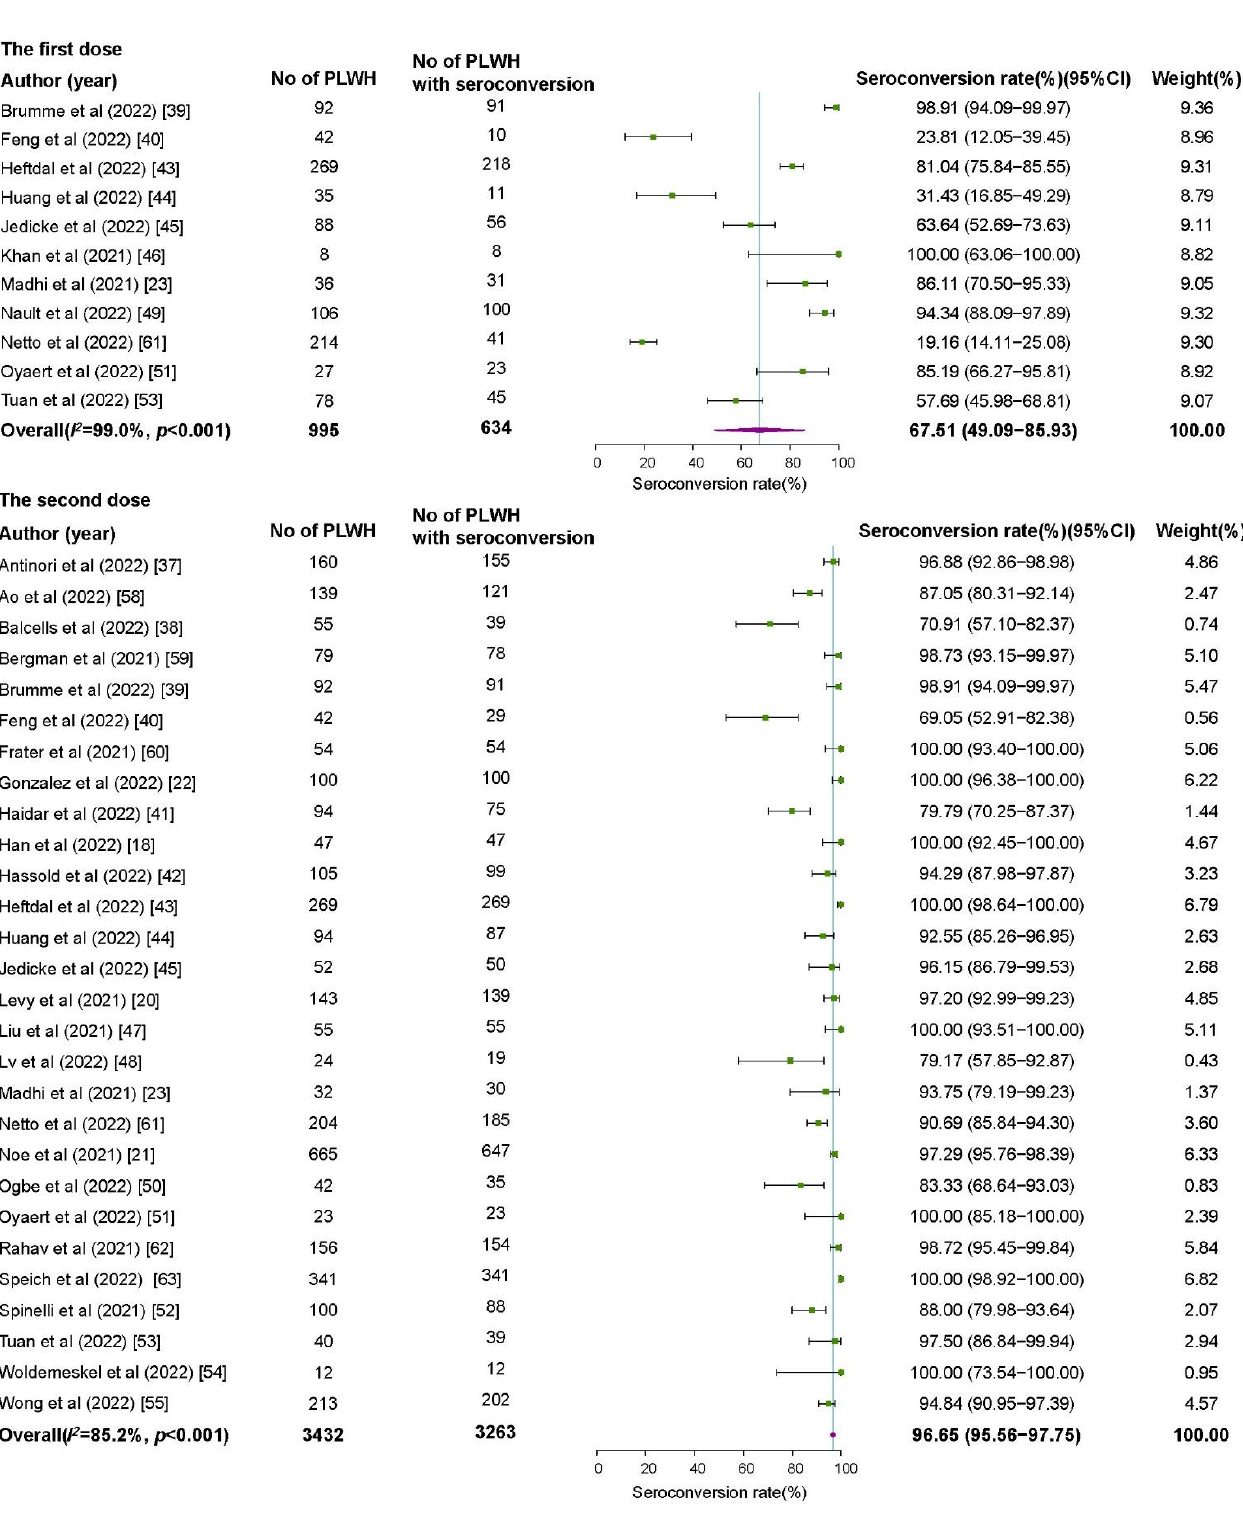
Figure 1. The seroconversion rates of SARS-CoV-2 antibodies among people living with HIV. PLWH: people living with HIV; CI: confidence interval.